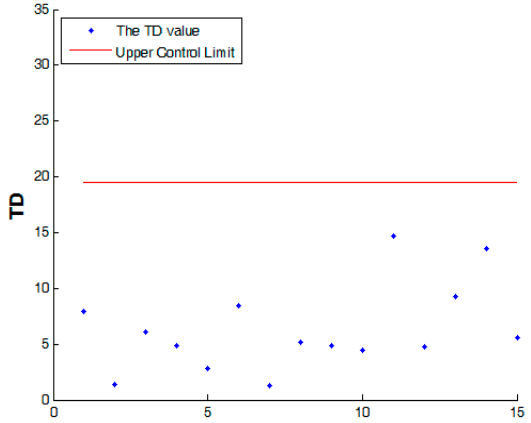
Figure 6. T 2 control chart of the sum of two-sine function by using the fifteen in-control profiles.